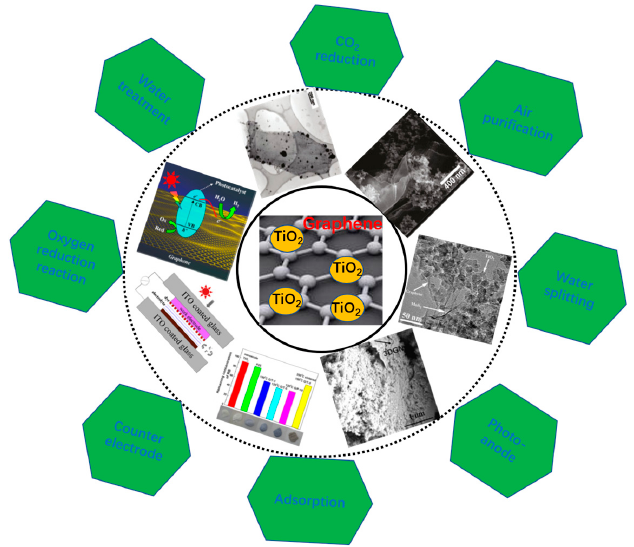
Figure 2. Overview of different research areas of graphene-TiO 2 composites. Reproduced with